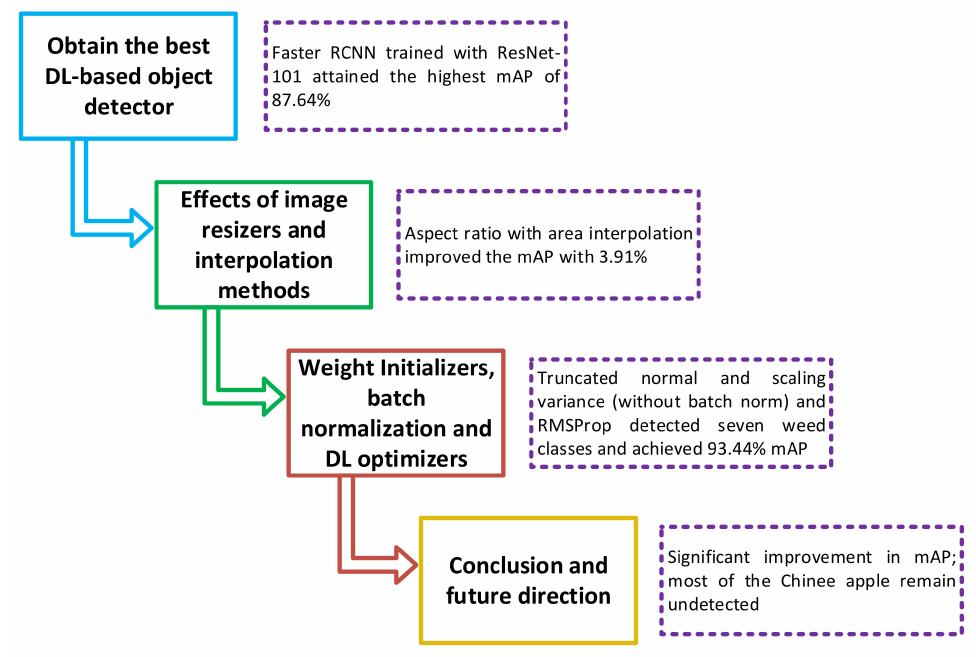
Figure 3. Highlights of the first step of the